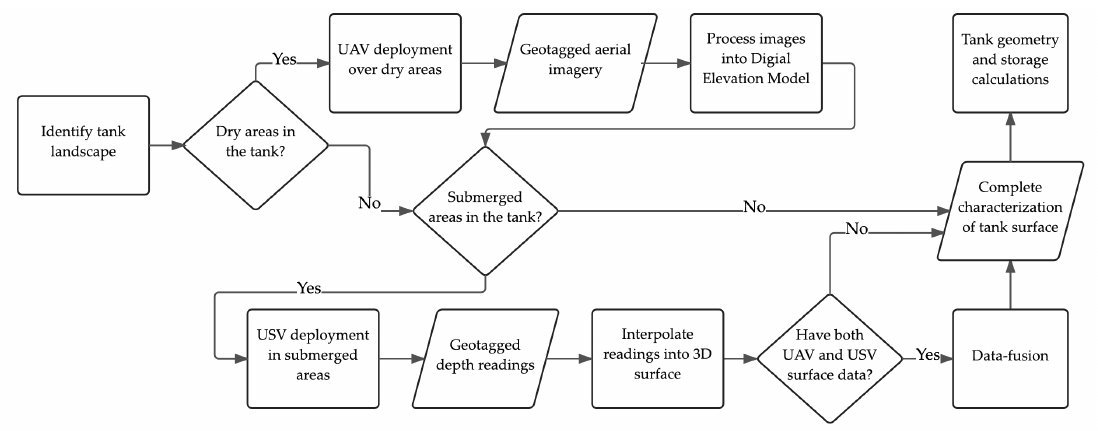
Figure 3. Proposed workflow for collecting surface data using small robots, including UAVs and USVs, to fully characterize tanks and small reservoirs in various wet and dry